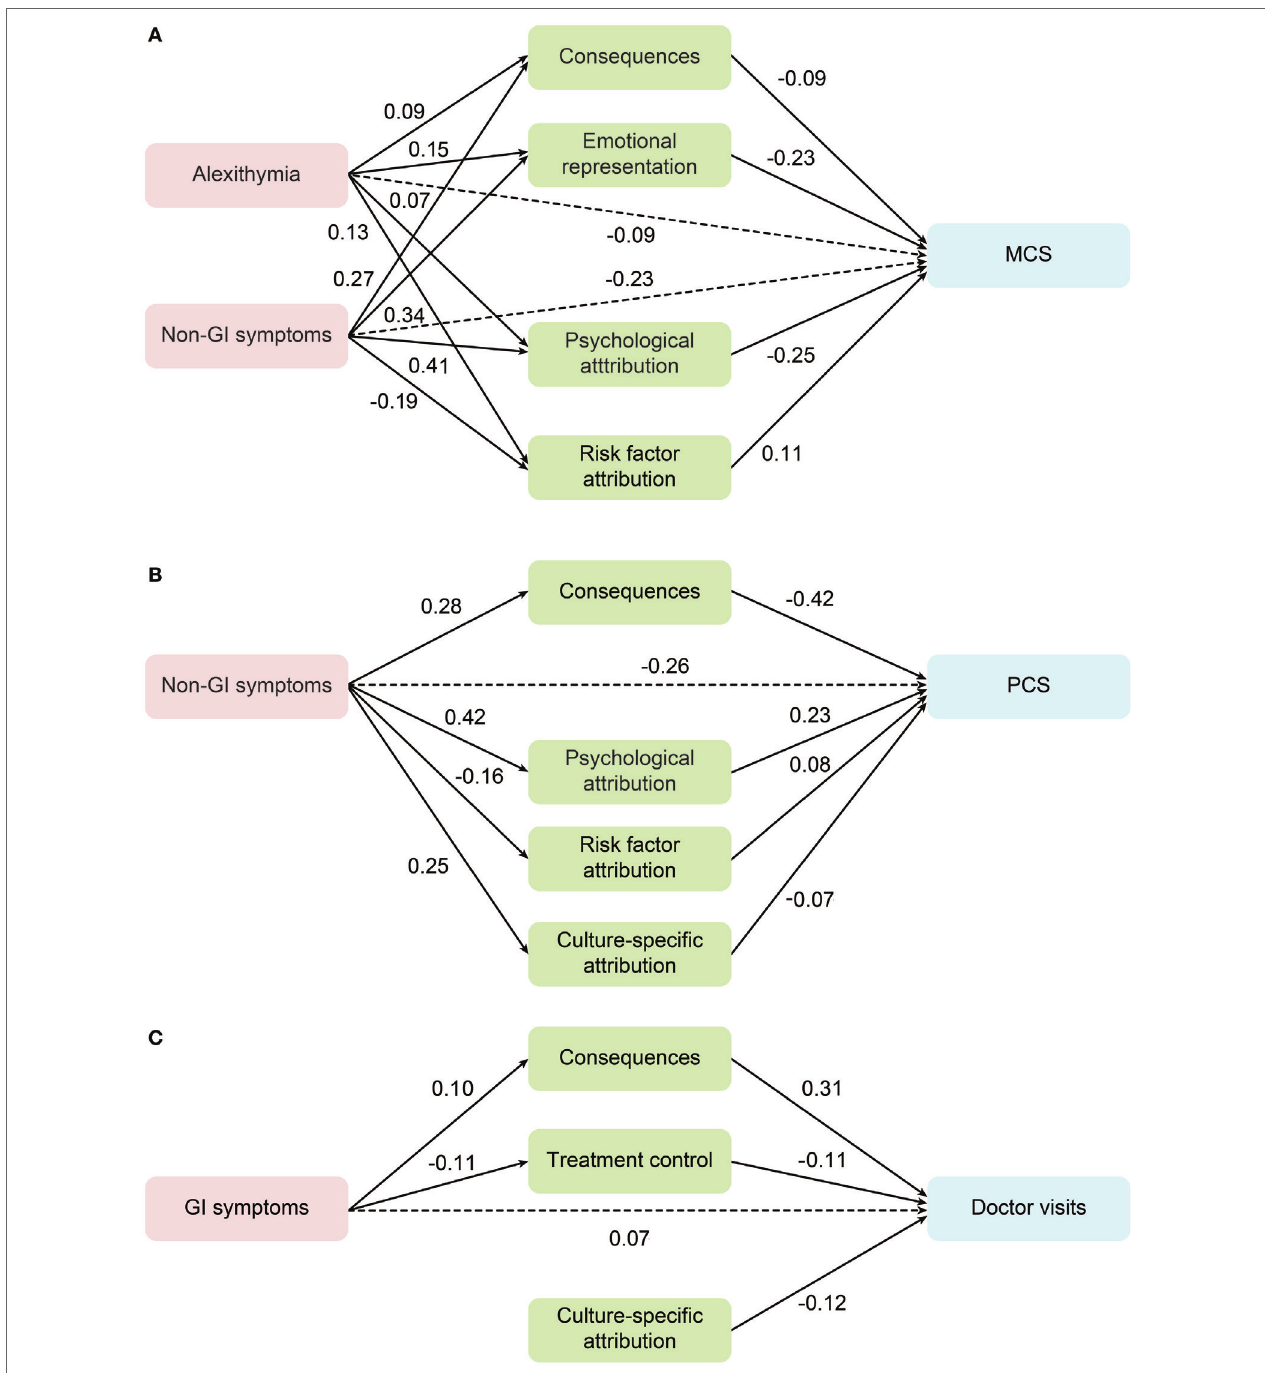
FigUre 1 | Mediation role of the illness perception between alexithymia, gastrointestinal and non-gastrointestinal symptoms, and outcomes in the functional gastrointestinal disorder group. (a) MCS, mental composite score; (b) PCS, physical composite score; (c) the frequency of doctor visits. Standardized estimates are shown for the significant regression paths. Residual errors are omitted from the